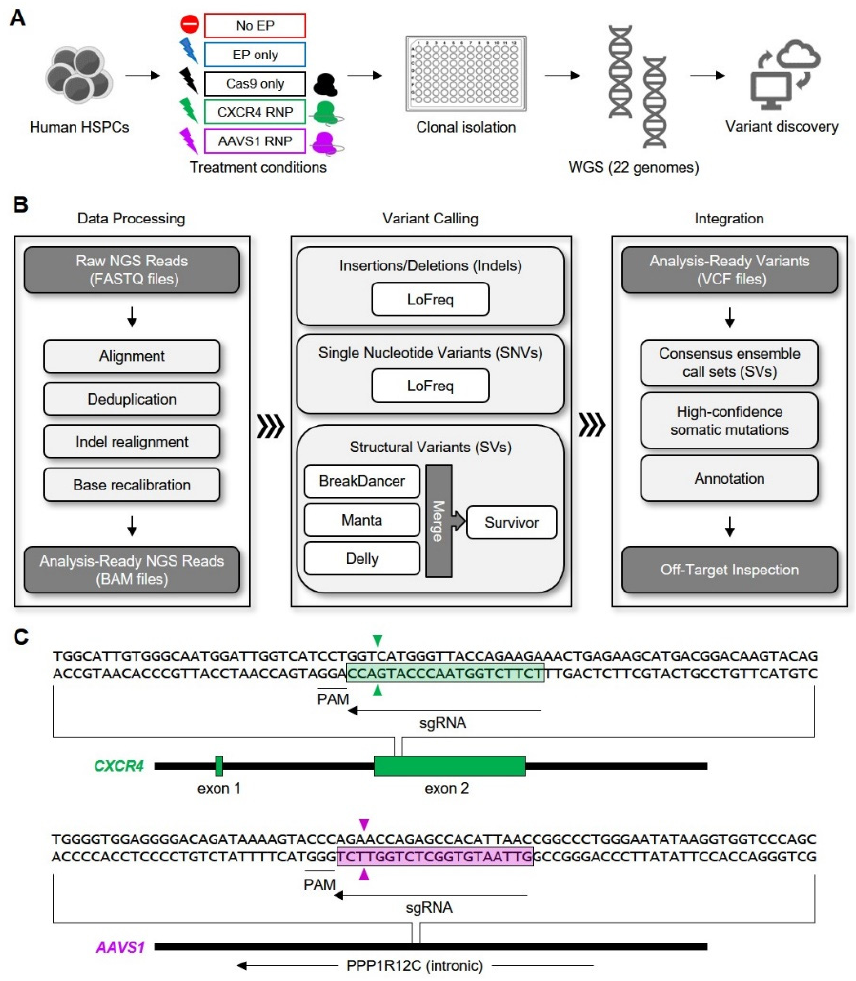
Figure 1. Genome-wide analysis of off-target CRISPR/Cas9 (clustered regularly interspaced short palindromic repeats/CRISPR-associated protein 9) activity in human hematopoietic stem and